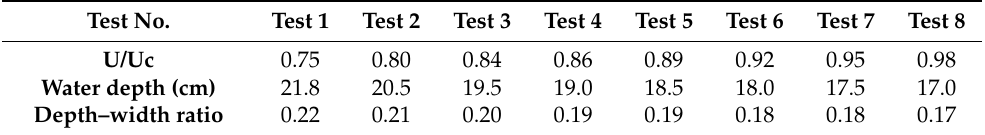
Table 1. Test characterization and conditions.